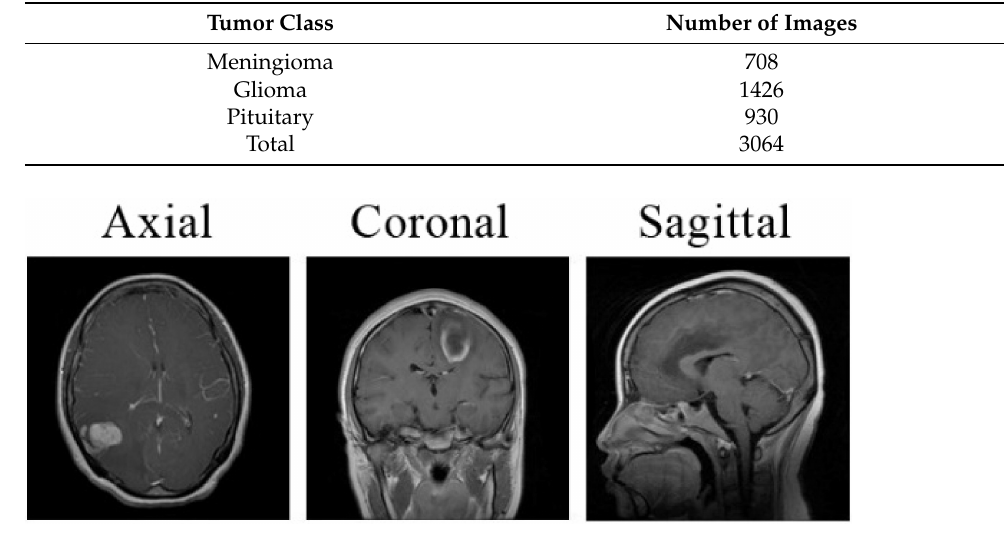
Figure 4. Representation of the three different planes of the MRI